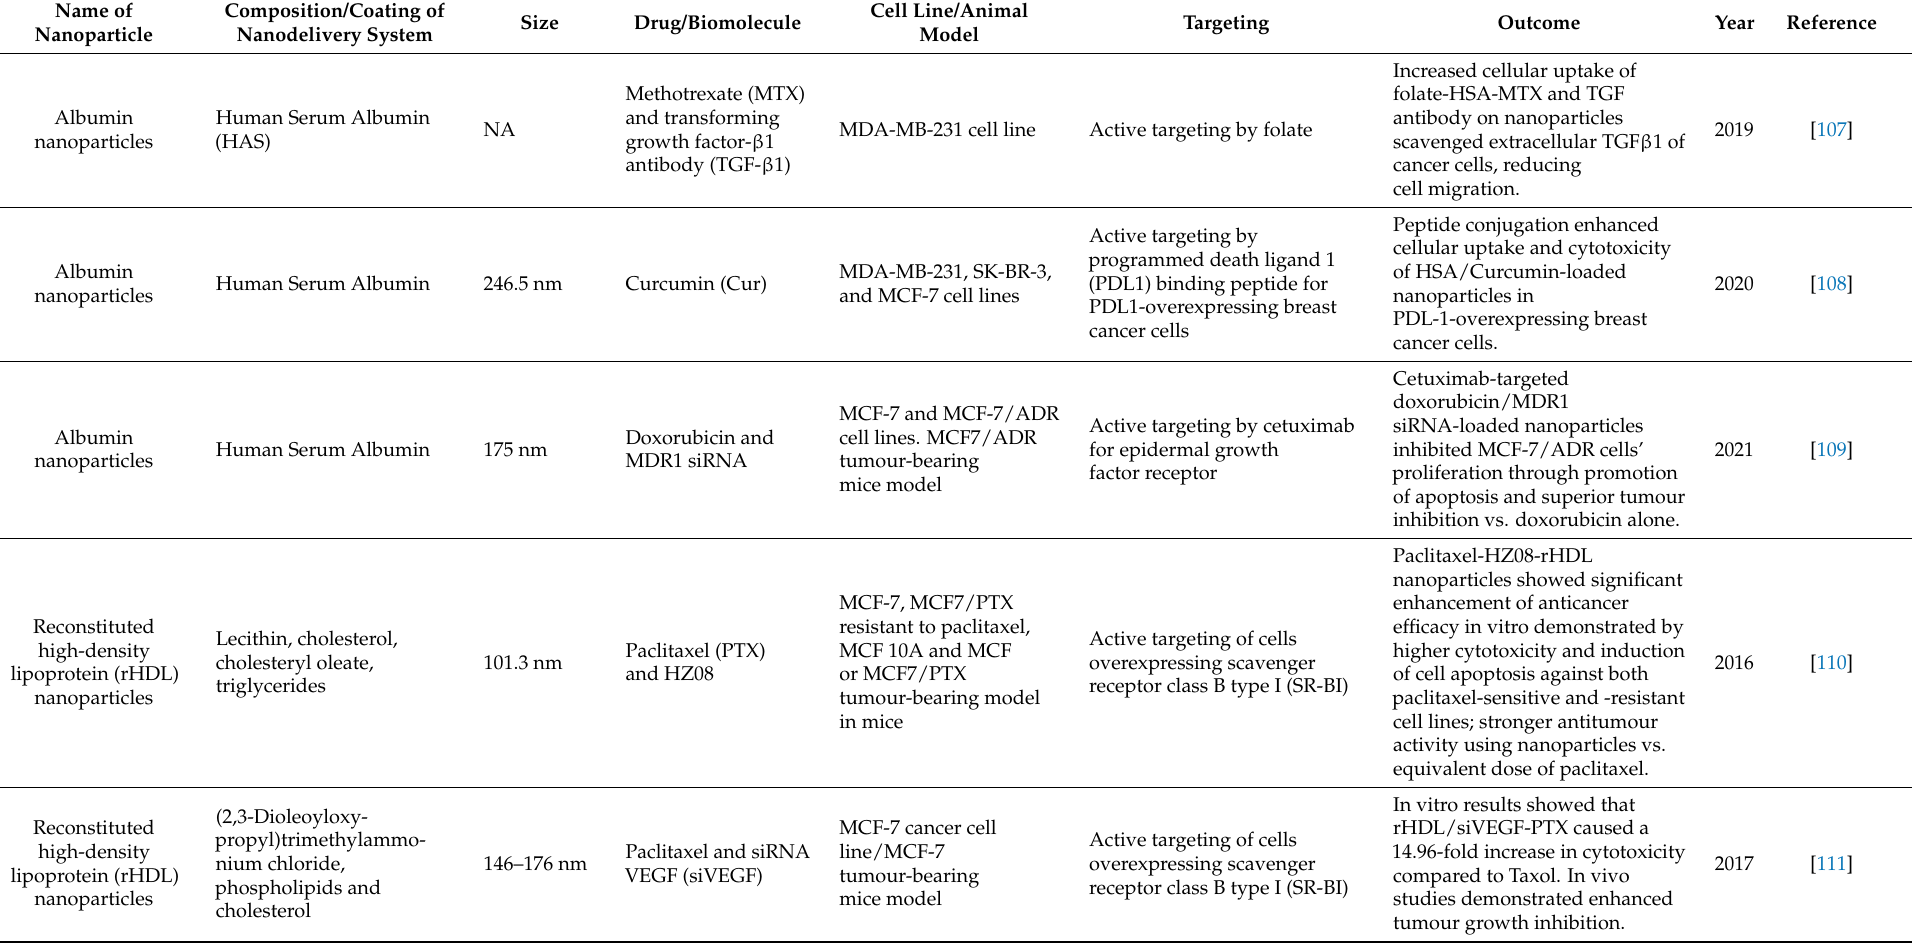
Table 3. Various biomimetic nanoparticles investigated in breast